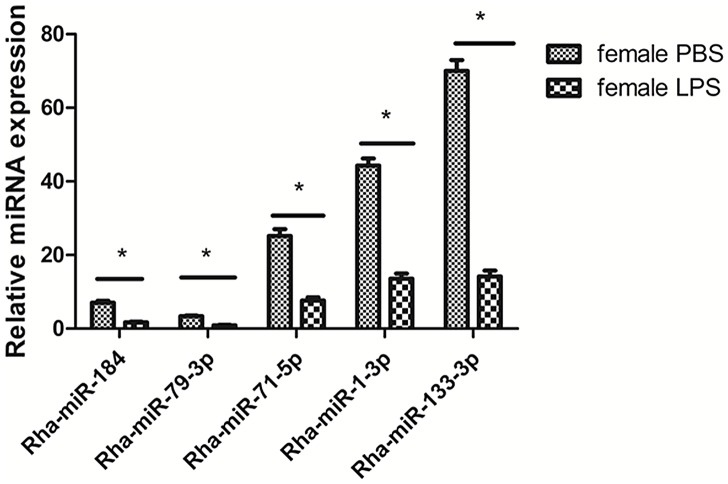
Investigation of the selected miRNAs in female ticks treated with PBS or LPS.* means P<0.01 by Student's t-test.